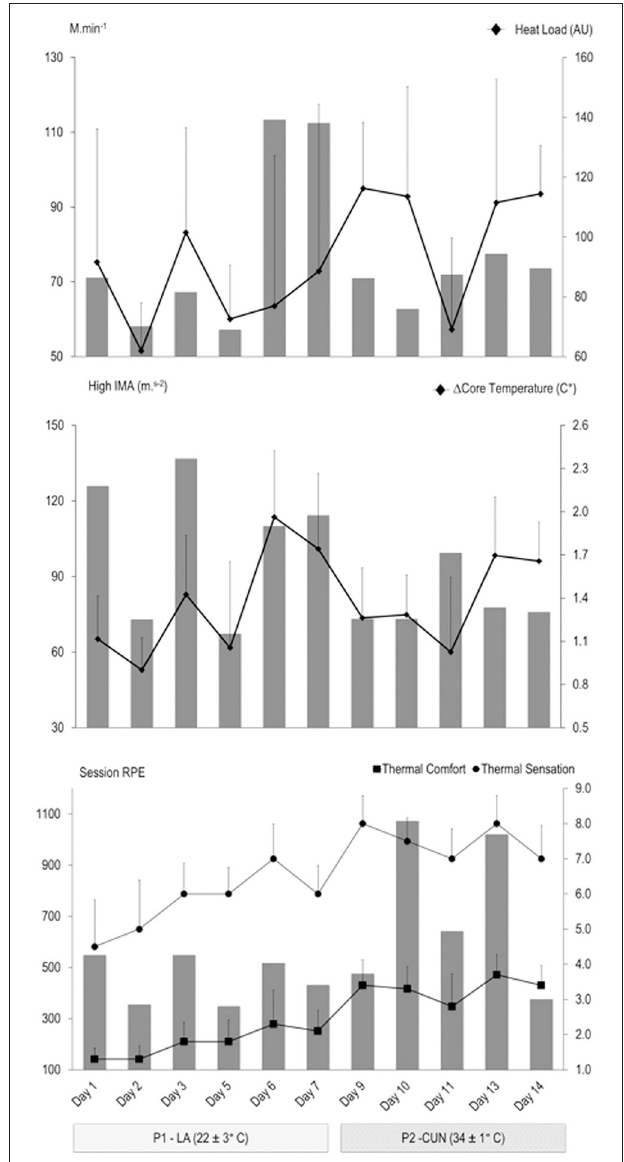
FIGURE 3 | Daily variations in training load and heat stress response during phase 1 in Los Angeles (P1—Los Angeles) and phase 2 in Cancun (P2—Cancun). There was no training on days 4, 8, and 12. Days 6 and 7 were international friendlies.